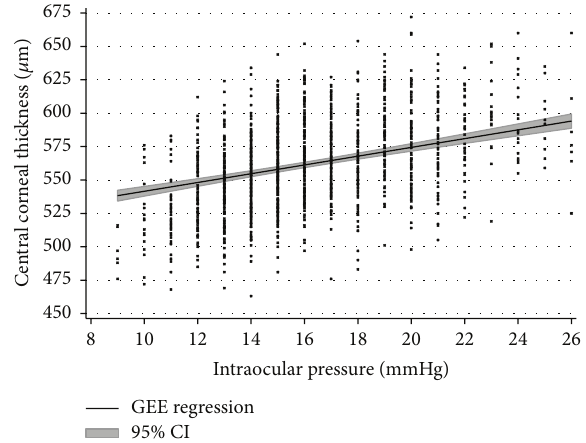
Figure 1: Association of central corneal thickness (CCT) as determined with SD-OCT and intraocular pressure (IOP). The correlation coefficient is 𝑟 = 0.45 ( 𝑝 < 0.001 ) and the regression equation is CCT (in 𝜇 m) = 509 + [3.29 ∗ IOP (in mmHg)].